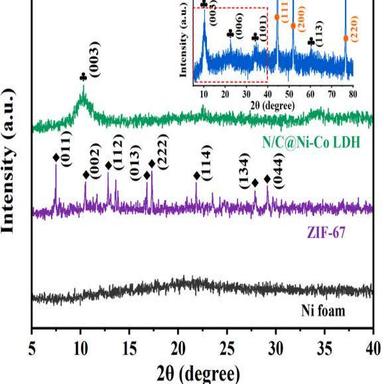
XRD patterns of Ni foam, ZIF-67 and N/C@Ni-Co LDH. Insert is the whole pattern of N/C@Ni-Co LDH nanosheet arrays grown on Ni foam.